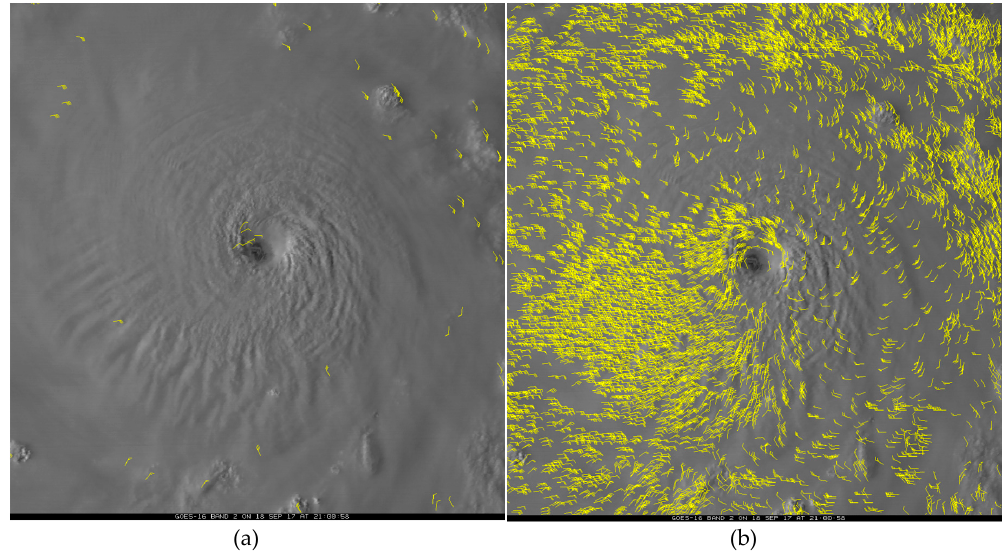
Figure 6. GOES-16 VIS imagery of Hurricane Maria (2017), overlain with: ( a ) Upper-level AMVs generated using operational processing settings, and ( b ) AMVs generated using all of the processing enhancements noted above to capture hurricane-scale flow fields.